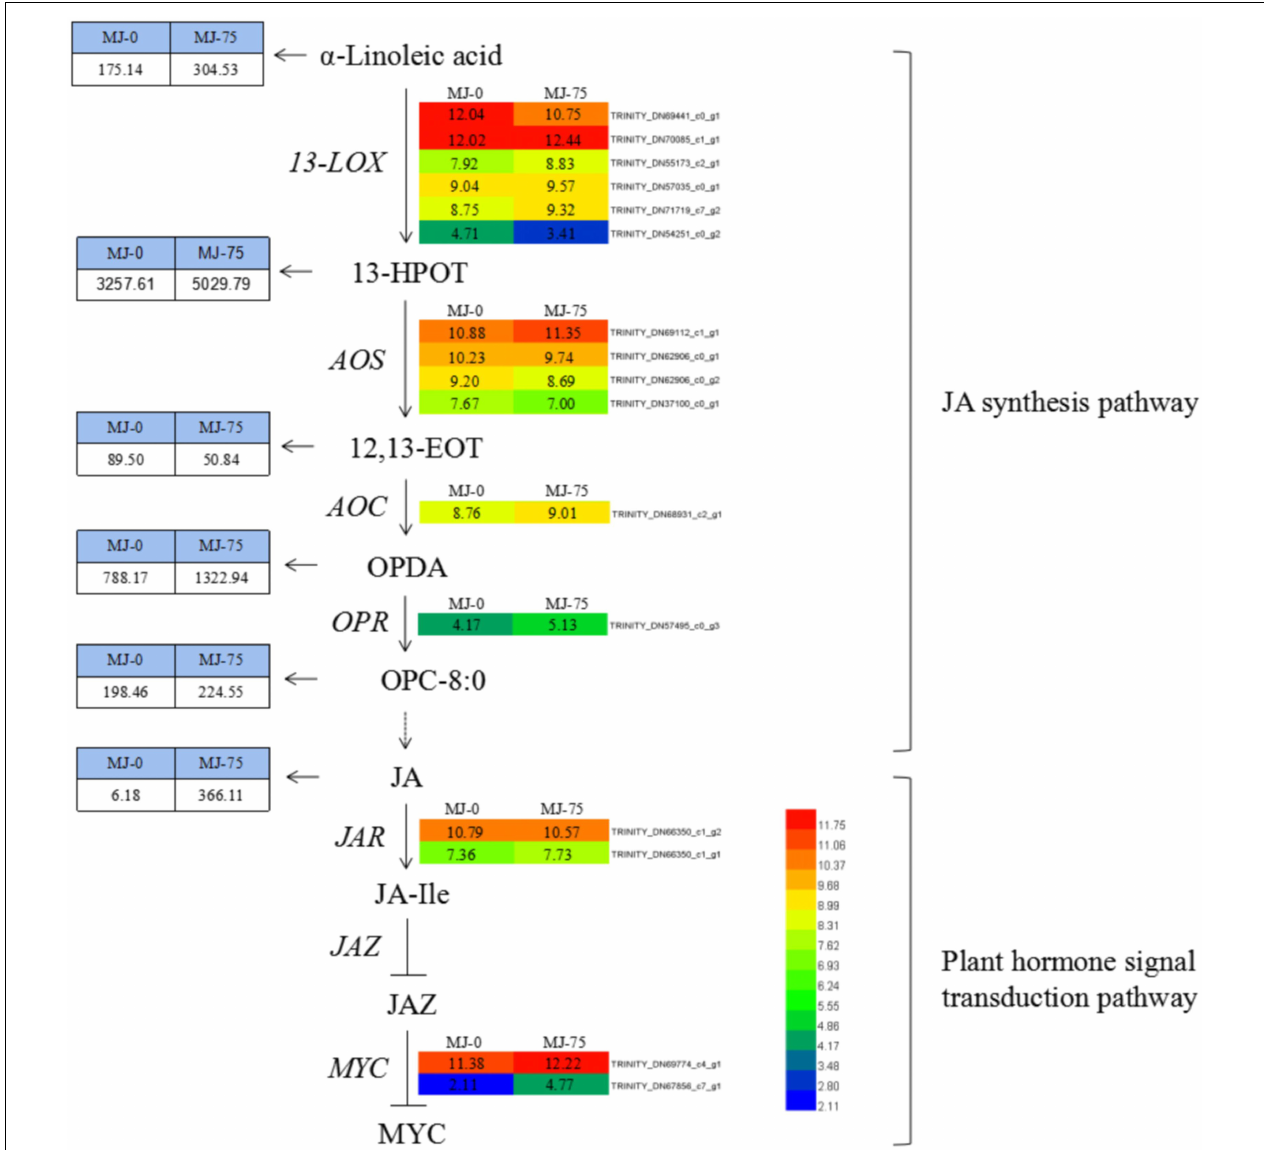
FIGURE 11 | DEGs and metabolites involved in the JA synthesis and plant hormone signal transduction pathway. Heat maps showed the normalized gene expression values which represent the means ± SD of three biological replicates ( N = 3). Metabolites contents showed the means ± SD of six biological replicates ( N = 6). Gene expression values are presented as FPKM normalized log2-transformed counts. JA, jasmonic acid; MeJA, methyl jasmonate; 13-LOX, lipoxygenase; 13-HPOT, 13-hydroxy linolenic acid; AOS, allene oxide synthase; 12, 13-EOT, 12, 13-epoxyoctadecatrienoic acid; AOC, allene oxide cyclase; OPDA, 12-oxo-phytodienoic acid; OPR, 12-oxo-phytodienoic acid reductase; OPC-8:0, 3-oxo-2-(2(Z)-pentenyl)-cyclopentane-1 octanoic acid; JAR, jasmonic acid-amino acid synthase; JA-Ile, jasmonic acid-isoleucine; JAZ, jasmonic acid